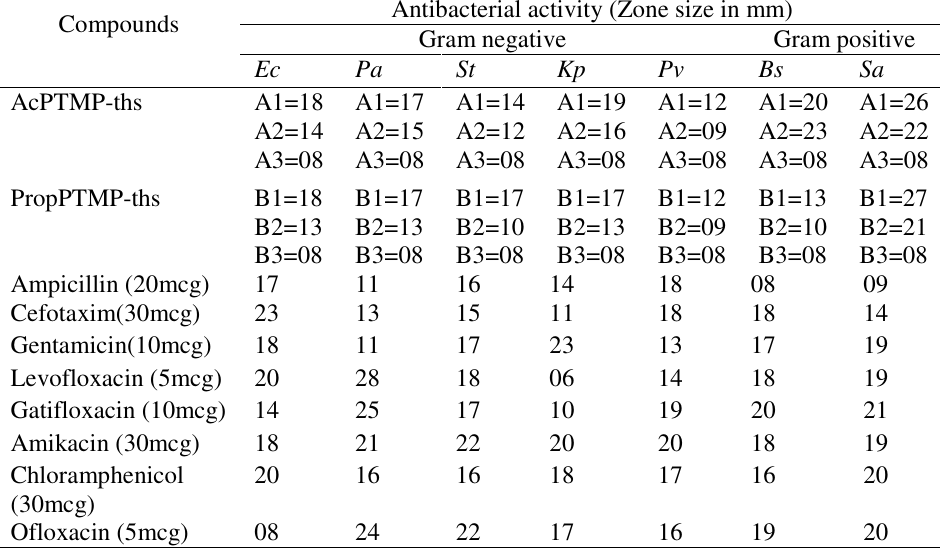
Table 3. Antibacterial activities of AcPTMP-ths and PropPTMP-ths with drugs. Antibacterial activity (Zone size in mm) Compounds Gram negative Gram positive Ec Pa St